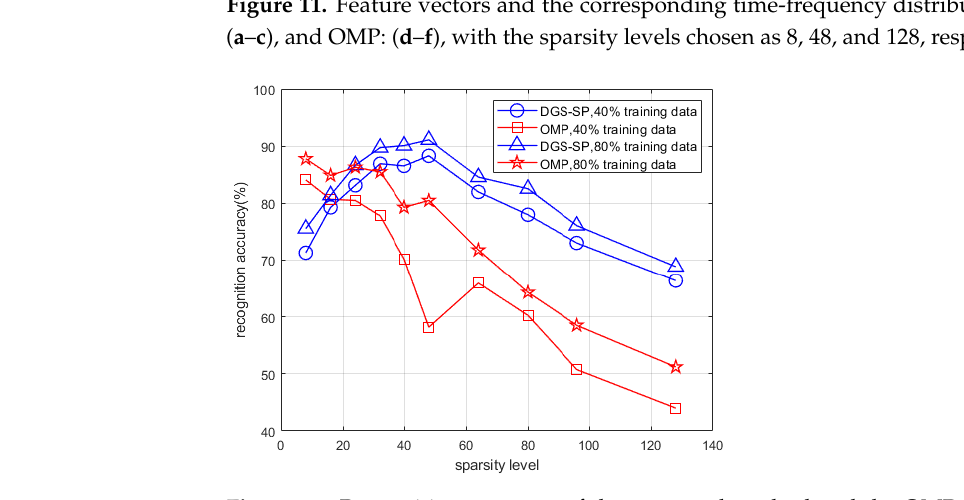
Figure 12. Recognition accuracy of the proposed method and the OMP method versus different sparsity levels.